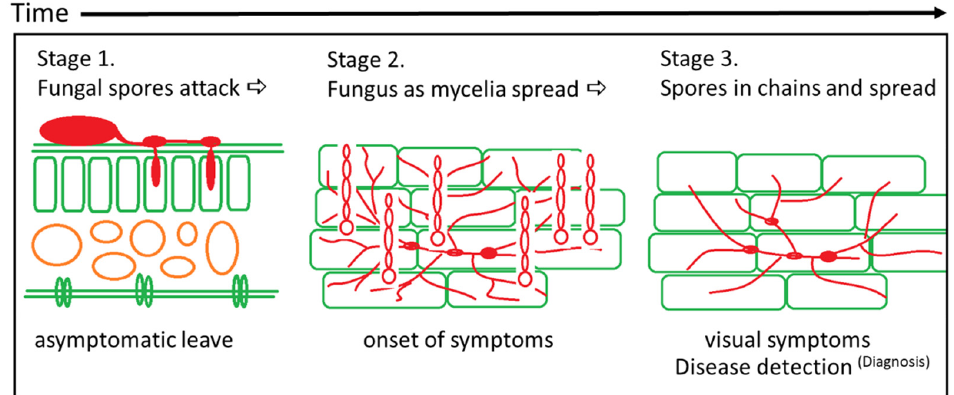
Figure 1. Signs and symptoms of plant disease development. Infographic: powdery mildew infection of rose. Where: stage 1, fungal spores attack; stage 2, the leaf may be asymptomatic or in the stage of beginning the on-set of symptoms; stage 3, the fungus produces the common sign of powdery mildew.